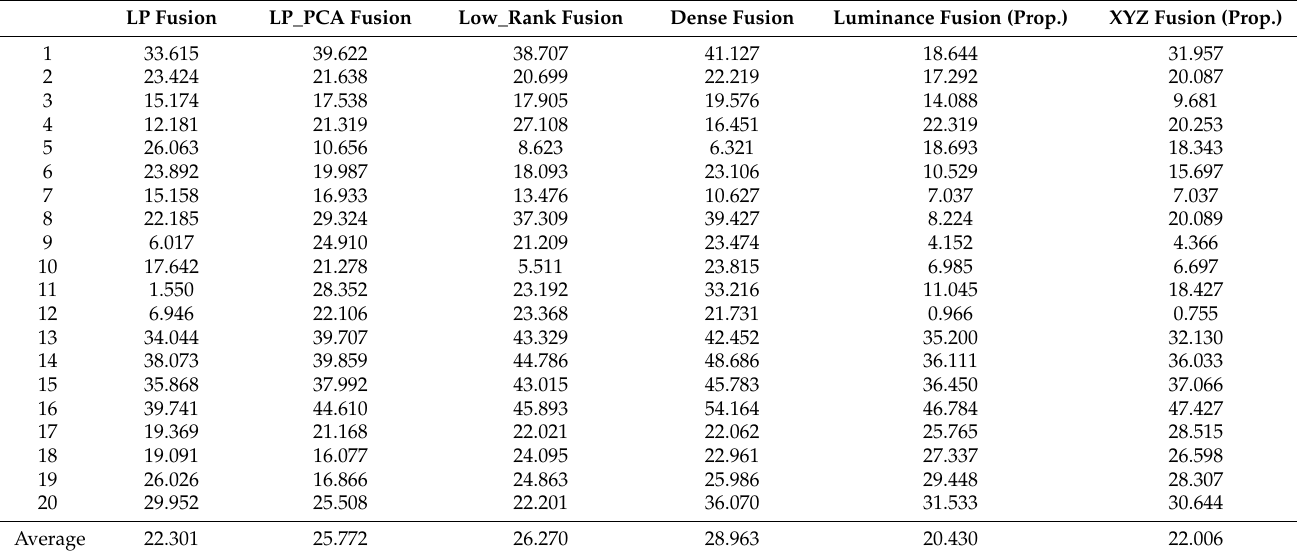
Table 3. Comparison of the BRISQUE image quality metrics.